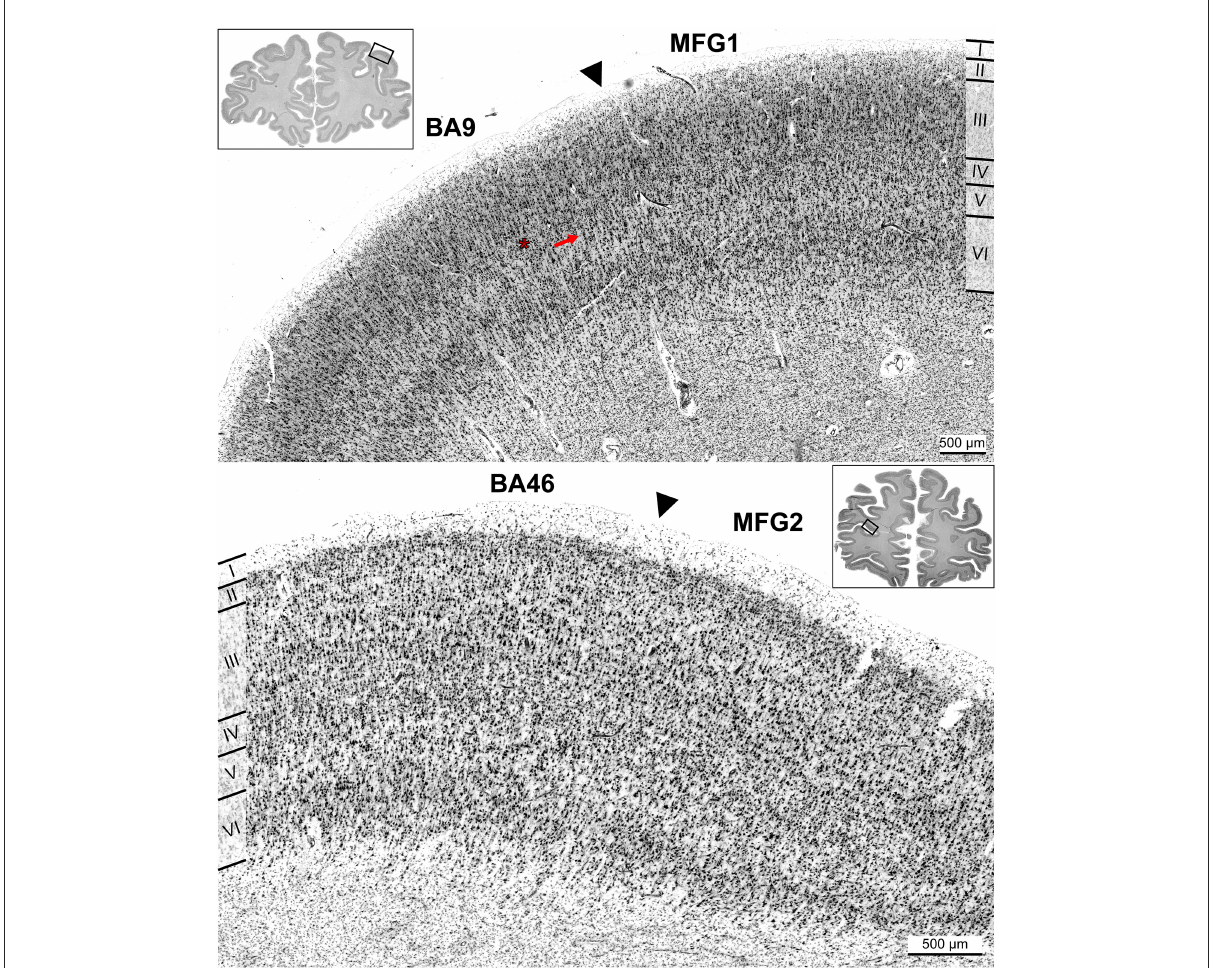
FIGURE8 Cortical borders of anterior dorsolateral prefrontal cortex areas and adjacent areas. Area MFG1 shared a border with BA9 (A) . The main distinction of BA9 was a thin and blurred layer IV (red asterisk) and large pyramidal cells in layer Va (red arrow) compared to area MFG1 (A) . Area MFG2 also bordered ventrally to BA46, shown exemplarily in brain BC13 (B) . Typical for BA46 was the prominent layer IV. Layer III had a slight gradient in pyramidal cell size, and infragranular layers were more prominent than in area MFG2. Arrowheads indicate these